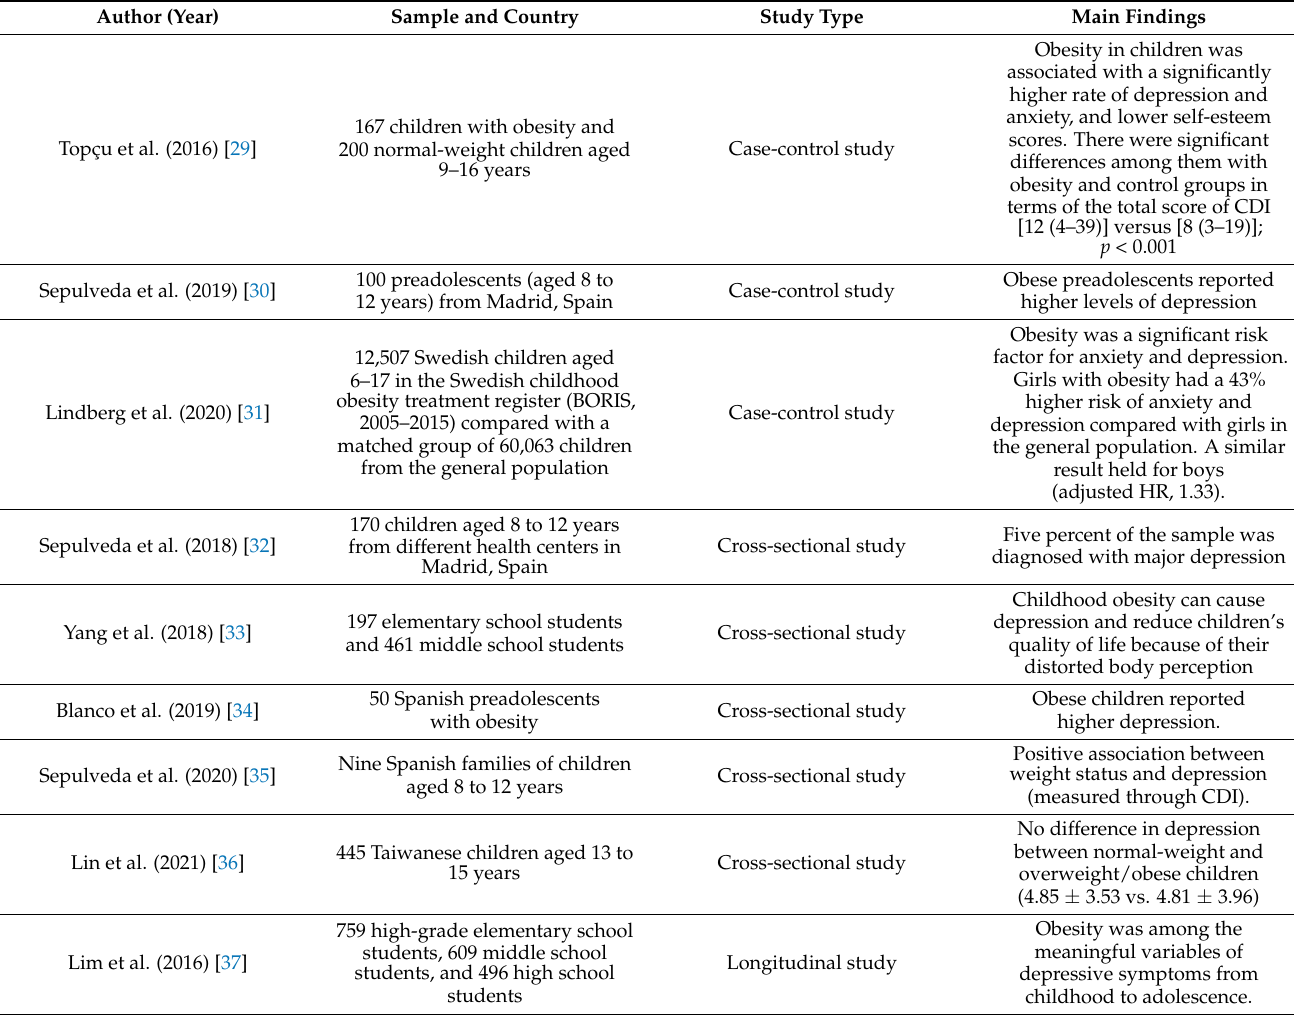
Table 3. Characteristics of studies that evaluated the association between childhood obesity and